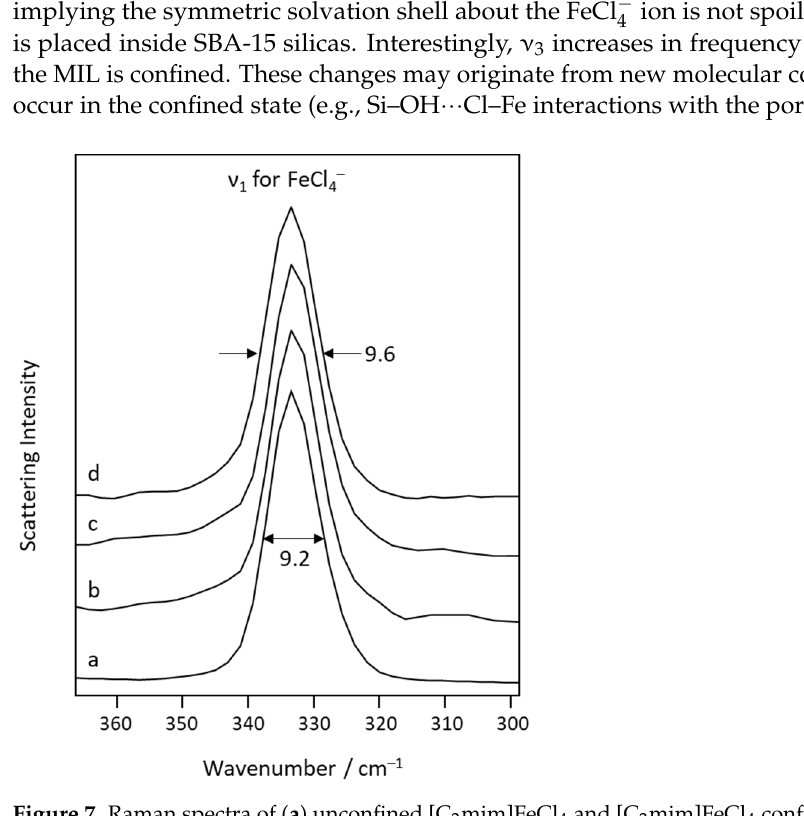
Figure 8. Far-IR spectra of ( a ) unconfined [C 2 mim]FeCl 4 and [C 2 mim]FeCl 4 confined within ( b ) 8.36, ( c ) 7.36, and ( d ) 5.39 nm mesoporous silica. Mid-IR spectra provide information about the imidazolium cations since all anion vibrations occur below 400 cm − 1 . As expected, the spectra are dominated by bands associ- ated with SiO 2 vibrations from SBA-15 that overlap and obscure many of the cation bands. Fortunately, the 850 to 600 cm − 1 region (Figure 9) contains only one relatively weak SiO 2 band. This band, which is attributed to symmetric stretching motions of O atoms relative to Si atoms, consists of overlapped transverse optic and longitudinal optic modes at ~810 and ~820 cm − 1 , respectively [75]. Multiple bands that originate from the [C 2 mim] + cations can be discerned in the IR spectra. Our band assignments follow the quantum chemical